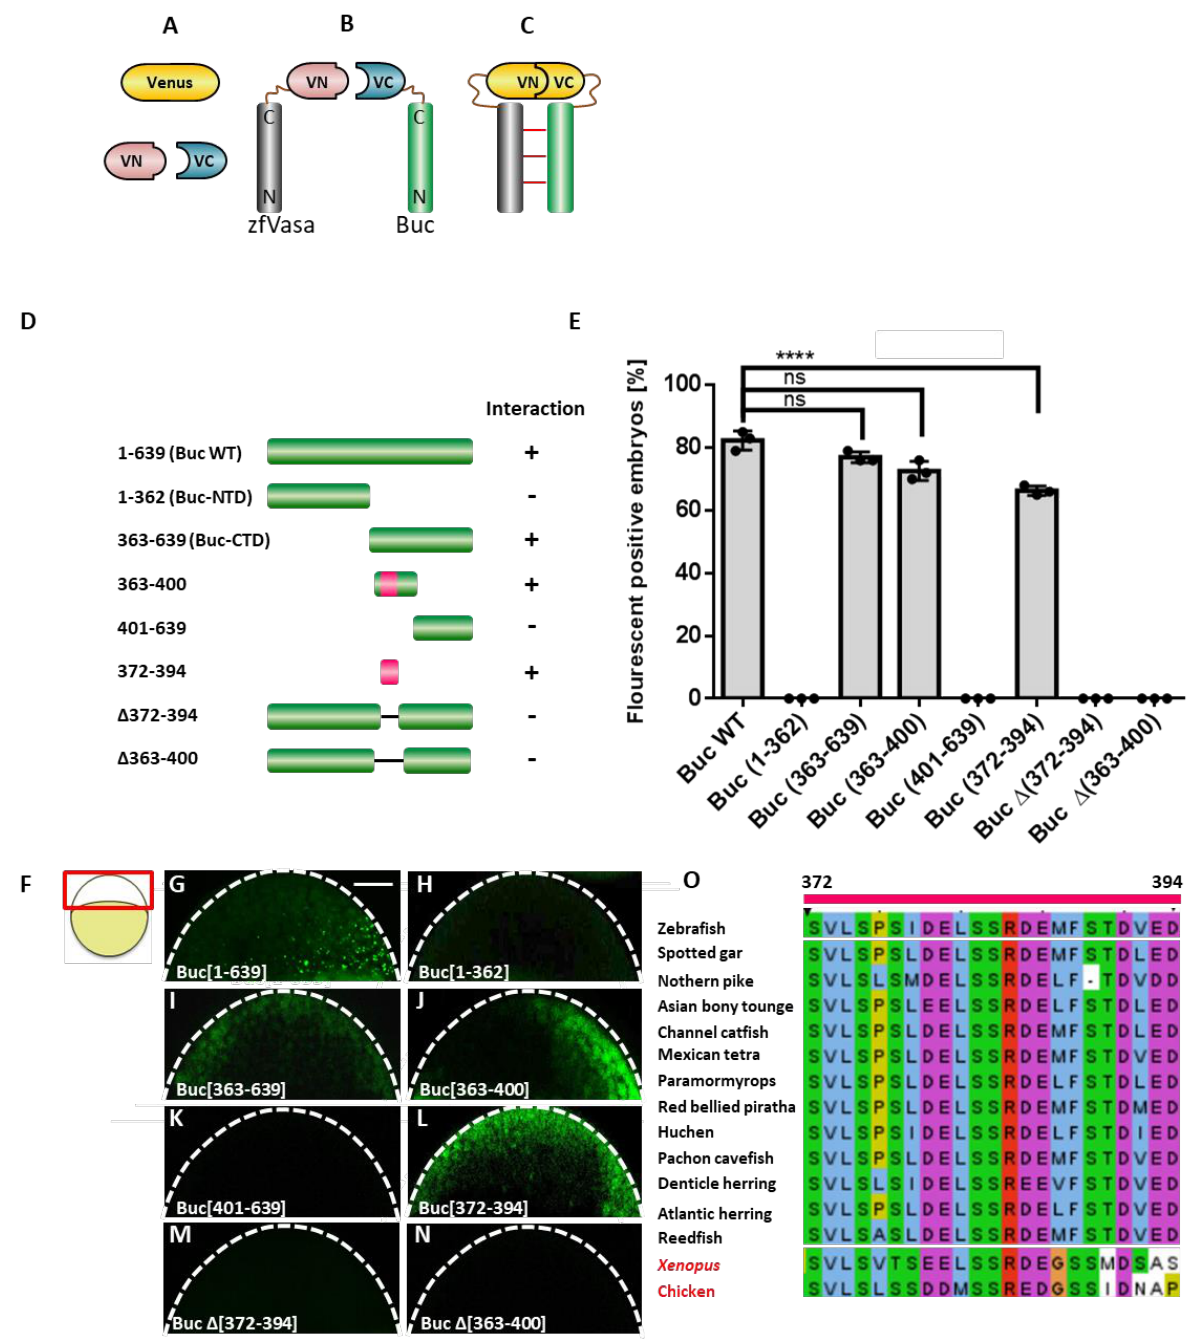
Figure 1. Mapping of the Vasa-binding motif in Buc (Buc-VBM). ( A – C ) Illustration of the BiFC assay. ( A ) Venus protein (yellow) is split into two nonfluorescent parts, Venus N-terminus (VN; rose) and Venus C-terminus (VC; blue) ( B ) Fusion of zfVasa (grey) and Buc (green) with VN and VC fragments, respectively. ( C ) Interaction of zfVasa and Buc (horizontal red lines) reconstitute a functional Venus protein forming a bimolecular fluorescent complex. ( D ) Schematic illustration of